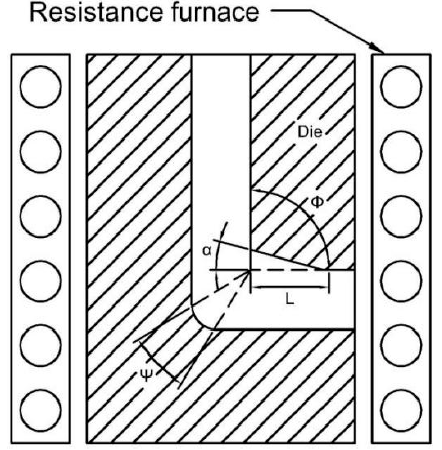
Figure 1. Schematic illustration of equal channel angular pressing (ECAP).